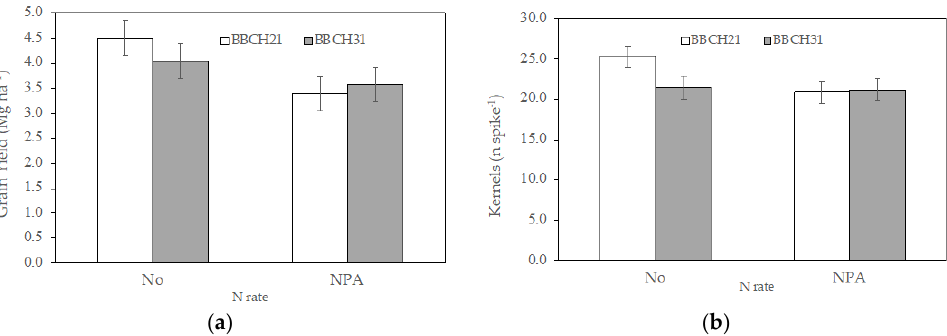
Figure 3. N rate × N timing interaction effect at Arezzo: ( a ) Grain yield; ( b ) Kernel number per spike. Vertical bars represent LSD ( p = 0.05).